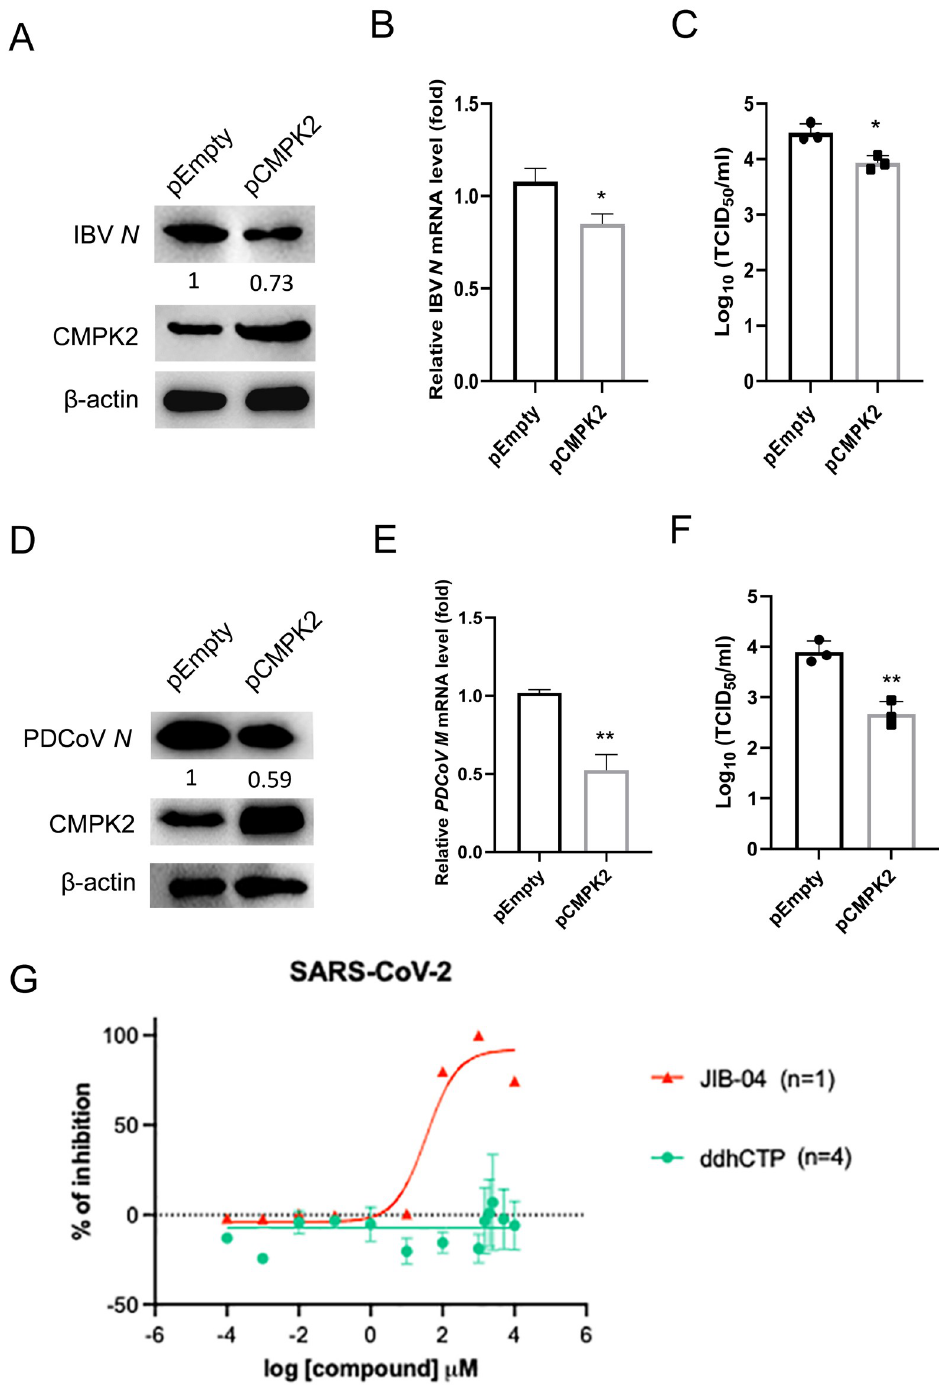
Fig 8. CMPK2 inhibits CoV replication with species differences. (A-C) DF-1 cells were transfected with empty vector and pCMPK2 for 24 h and then infected with IBV at MOI of 5. The cell lysates harvested at 20 hpi were analyzed by western blotting ( A ), total RNA of the cells was extracted and analyzed by qRT-PCR ( B ), and PDCoV titers in the culture supernatants were measured as TCID 50 ( C ). (D-F) LLC-PK1 cells were transfected with empty vector and pCMPK2 for 24 h and then infected with PDCoV at MOI of 0.1. The cell lysates harvested at 20 hpi were analyzed by western blotting ( D ), total RNA of the cells was extracted and analyzed by qRT-PCR ( E ), and PDCoV titers in the culture supernatants were measured as TCID 50 ( F ). (G) Dose–response curve of wild-type SARS-CoV-2 replication with JIB-04 or ddhCTP treatment. MA104 cells were treated with indicated compound for 1 h and